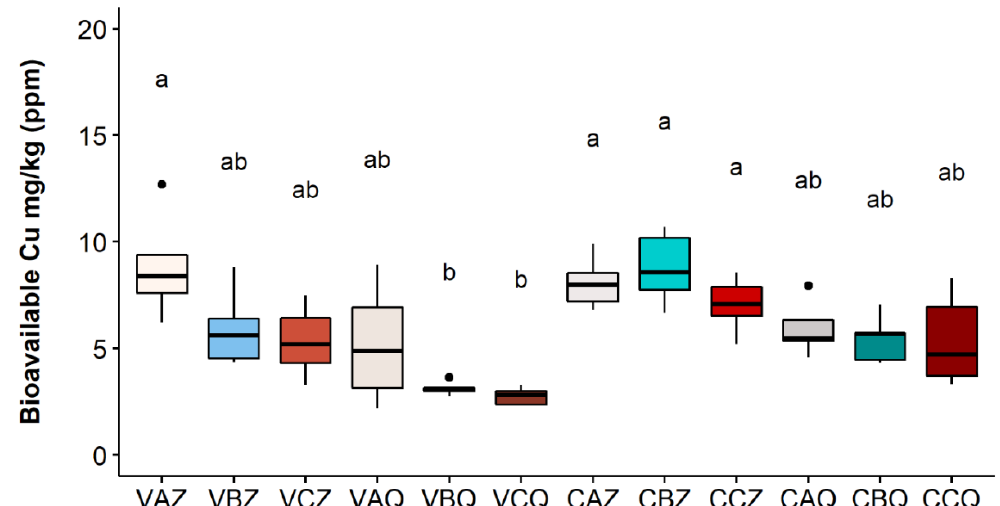
Figure 7. Bioavailable Cu concentration in each sample in 2021. Lower case letters refer to Dunn’s multiple comparisons (Benjamini–Hochberg p -value adjustment, α -level = 0.05). Codes legend: the first letter refers to the vineyard; (C) Castelplanio, (V) Varano. The second letter refers to the thesis: (A) Cu treatments, (B) Alternate treatments with Cu and chitosan, and (C) Chitosan treatments. The third letter refers to the depth: (Z) 0–20 cm, (Q) 20–40 cm.